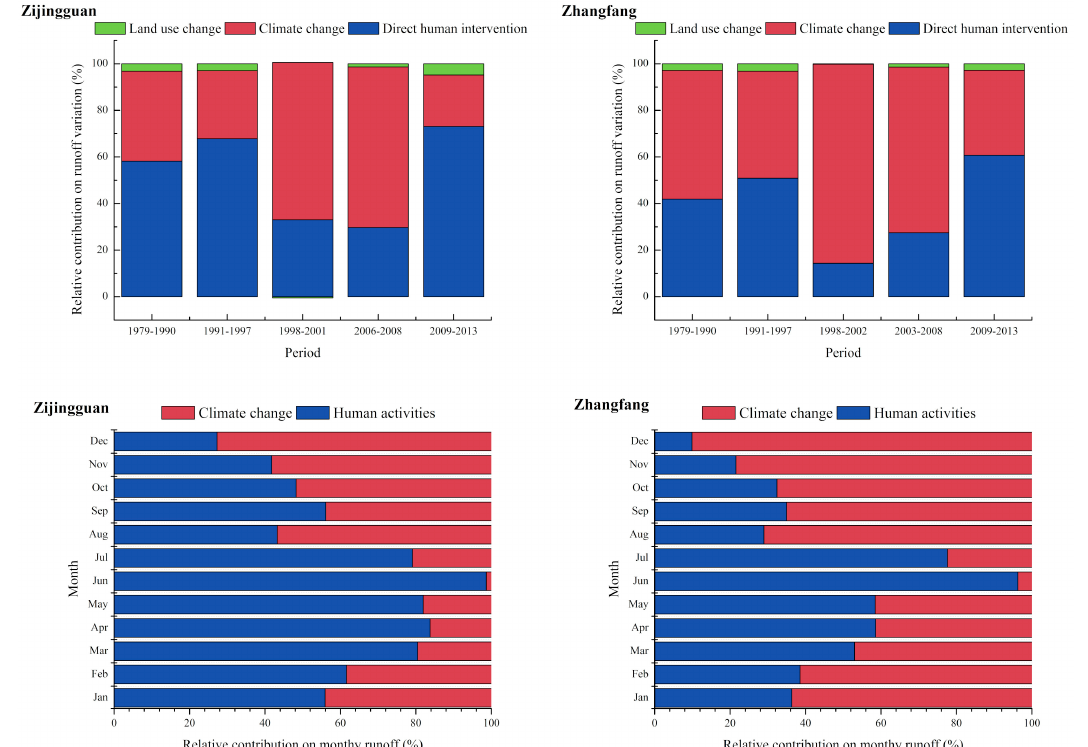
Figure 9. The runoff changes attributed to the climate change and human activities (land use change and direct human intervention) (Note: Attribution analysis of monthly runoff change was analyzed for the entire study period).